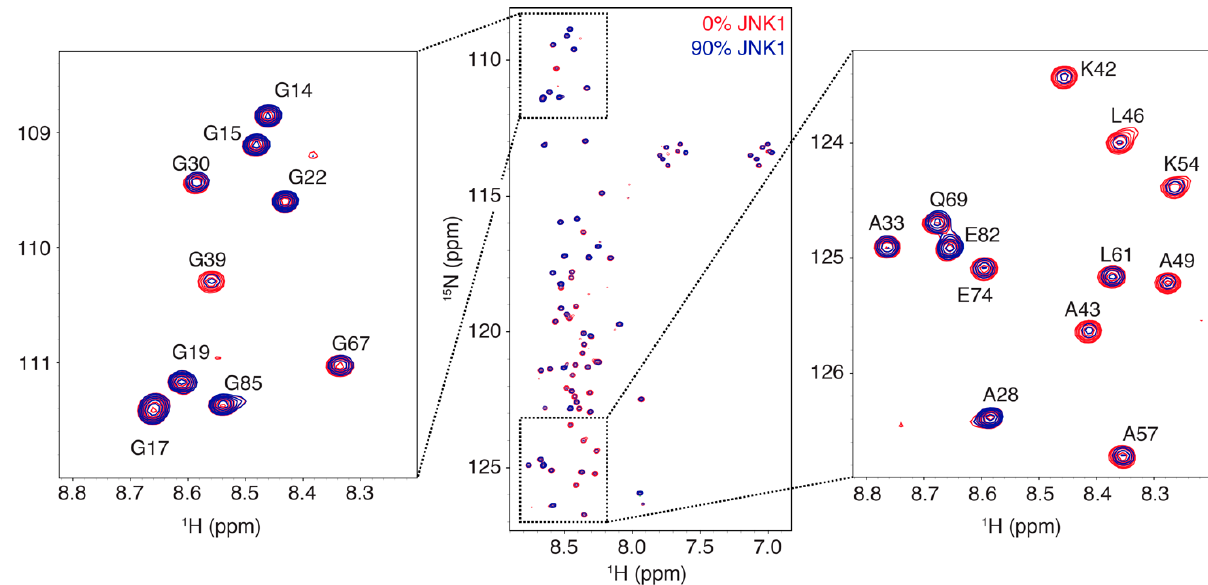
Figure 1. Superposition of the 1 H- 15 N HSQC spectrum of the intrinsically disordered regulatory domain of MKK4 (residues 12–86) in the absence (red) and presence (blue) of the JNK1 kinase (MKK4:JNK1 molar ratio of 0.9). Two selected regions are shown as zooms with labels indicating the resonance assignments.